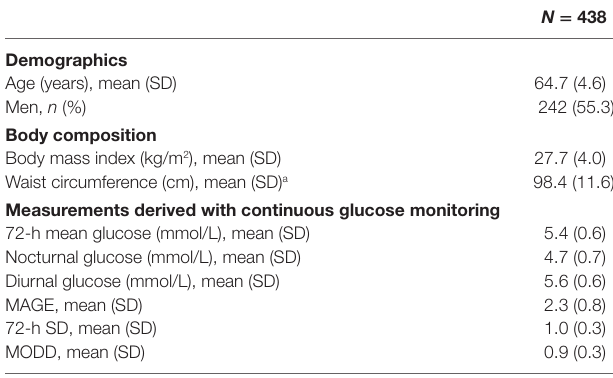
TaBle 1 | Characteristics of the total study